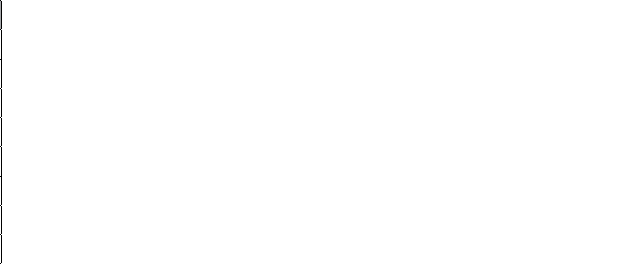
Table 3. Marine diesel engine specifications.